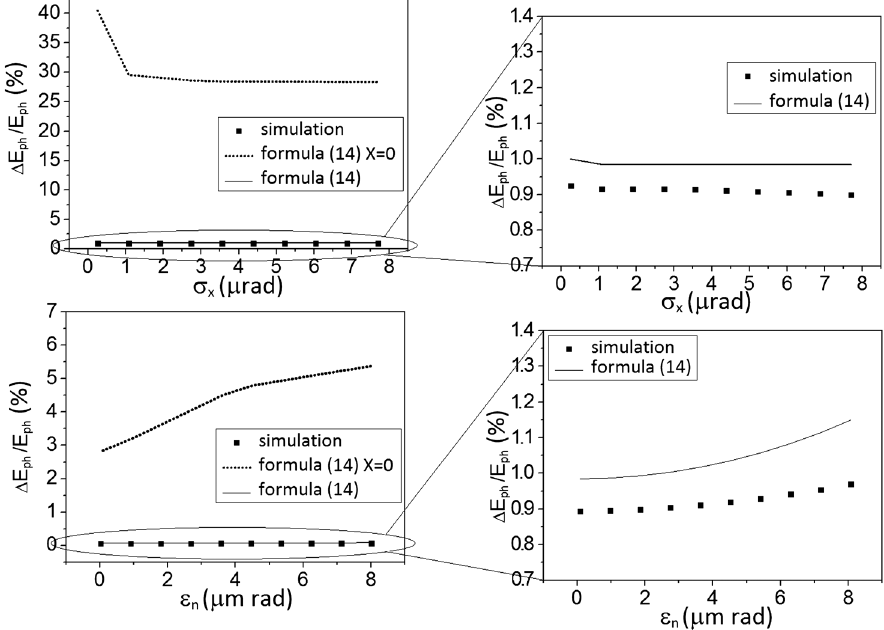
=E FIG. 8. Case F: Δ E (%) value from CAIN simulation vs formula (14) without and with X correction as a function of σ x ( μ m) ph ph (top line) and of ϵ n ( μ m rad) (bottom line) at fixed θ